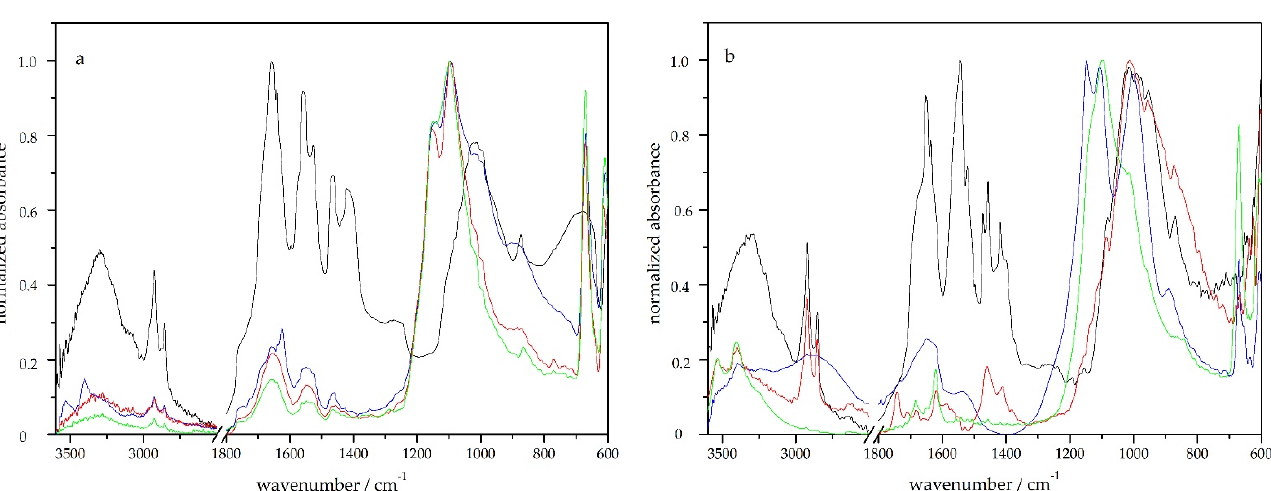
Figure 11. ATR-FTIR spectra of bone ( a ) and tooth ( b ) immersed in 75% sulfuric acid for 2 h (blue line), 6 h (red line), 24 h (green line) and original sample (black line).